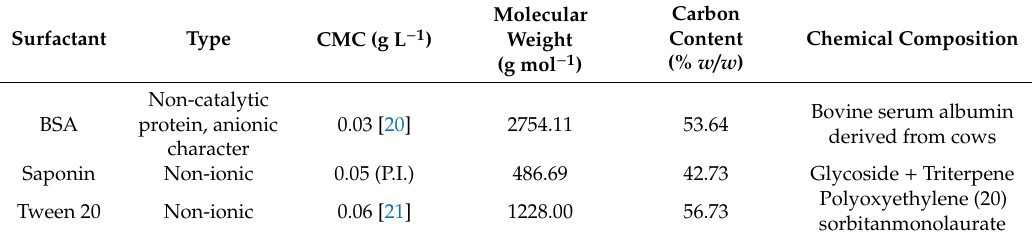
Table 1. Characteristics of the surfactants employed. P.I. stands for the online product information